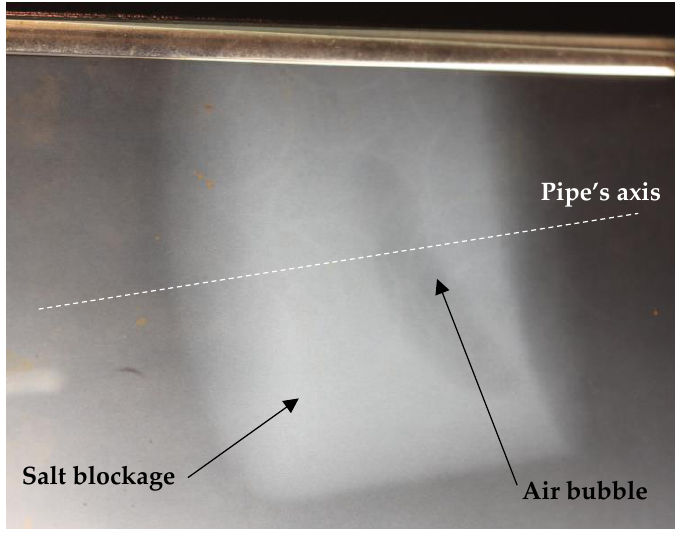
Figure 3. Lateral view of a scintigraphy from a salt blockage inside a test pipe.